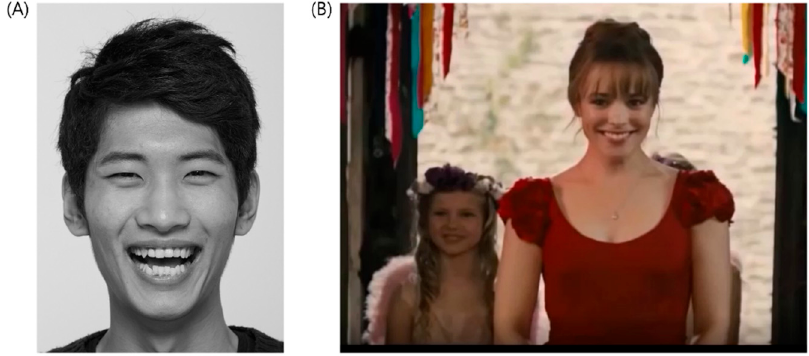
Figure 1. Stimuli used in posed and spontaneous facial emotion task. ( A ) Posed happy smiles. ( B ) Spontaneous happy smiles (film clip was taken from “About Time” movie clip).